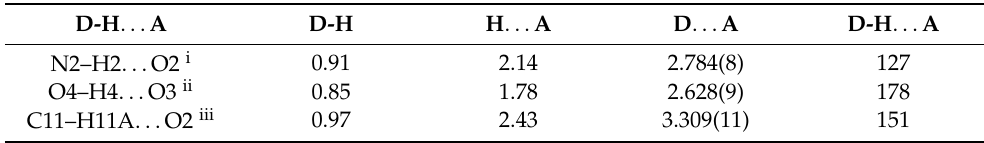
Figure 3. A polymeric 1D chain in [ Cu 2 (EDPB)•H 2 O] n , extended in 101 . H atoms omitted for clarity.